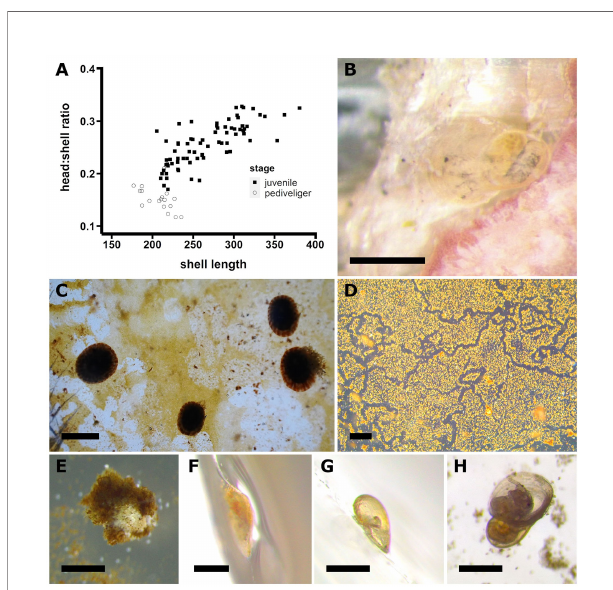
FIGURE 13 | Post-metamorphic morphologic and behavioral changes observed in limpets. Variation of the head:shell ratio in relationship with the animal growth in P . aspera ; head size was measured as eye distance relative to the shell length and shell length was measured as: protoconch + teleoconch (A) . P. aspera juvenile 10 days post-settlement showing body pigmentation (B) . P. candei juveniles around 2 months post-settlement showing shell pigmentation and grazing behavior on Ulvella lens bio fi lm (C) . Grazing marks left by the juveniles of P. candei on Navicula incerta bio fi lm, 7 days post-settlement (D) . P. aspera juvenile with the shell totally covered by surrounding environmental elements, ca. 7 weeks post-settlement (E) . P . candei juvenile placed vertically and reaching the water level (F) . P . candei juvenile desiccated due to stay above the water level (G) . P. aspera juvenile accidentally upturned, 1 month post-settlement (H) . Scale bar = 200 µm (B, F – H) , 500 µm (E) , and 1 mm (C, D)